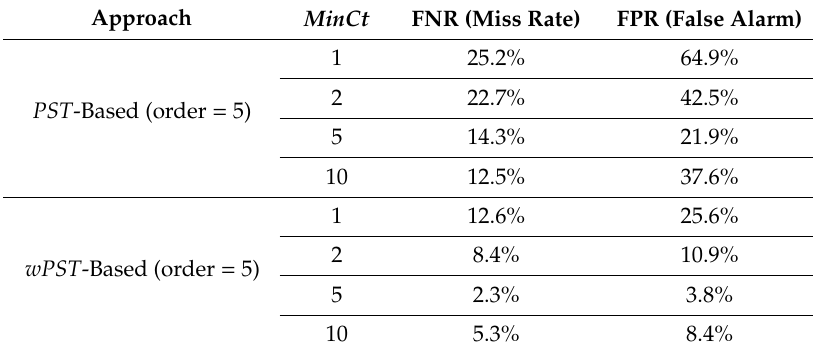
Table 10. Performances for wPST and PST.